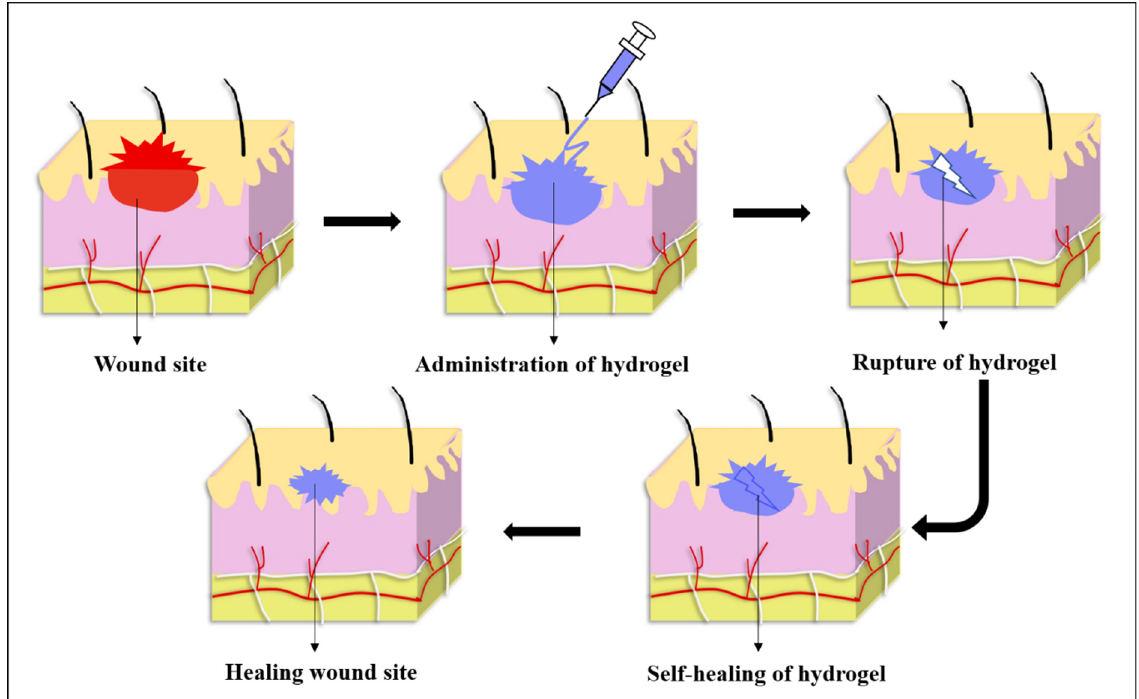
Figure 5. Application of self-healing hydrogel in wound healing.